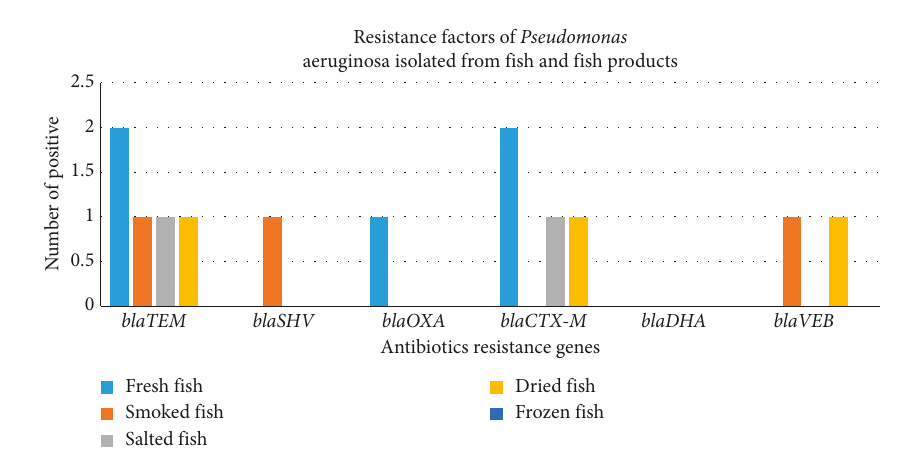
Figure 3: Resistance factors of Pseudomonas aeruginosa isolated from fish and fish products.